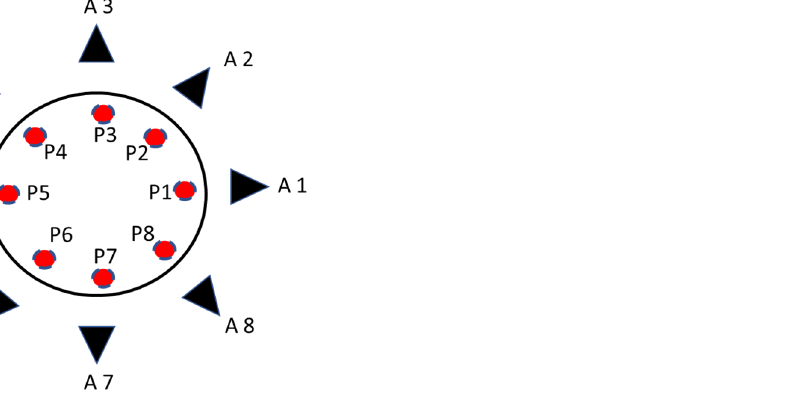
Figure 17. Proposed scenario of the antenna array for tumor detection (antennas: A1 to A8 and the tumor position P1 to P8).